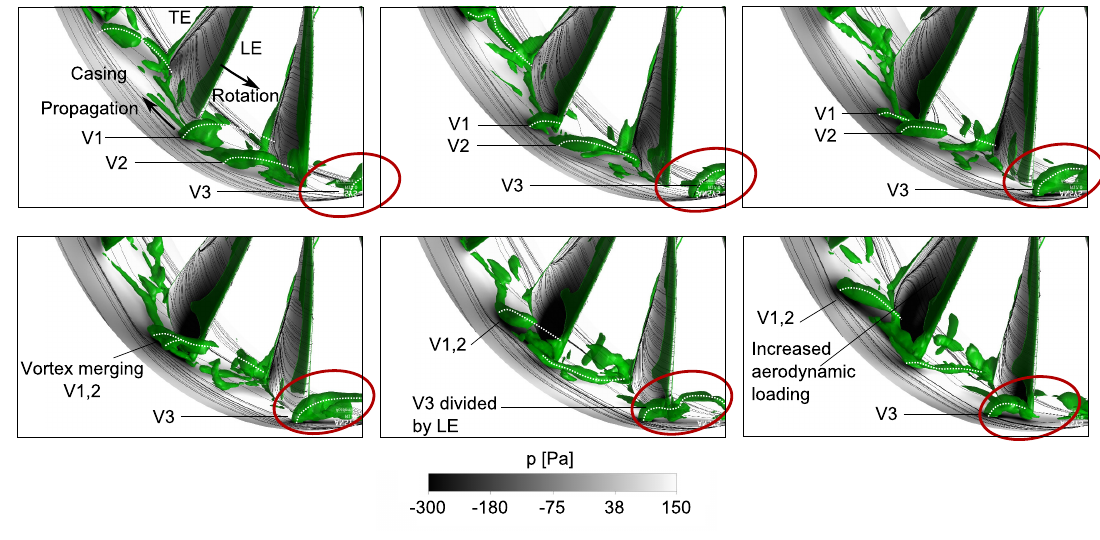
Figure 11. Vortex dynamics